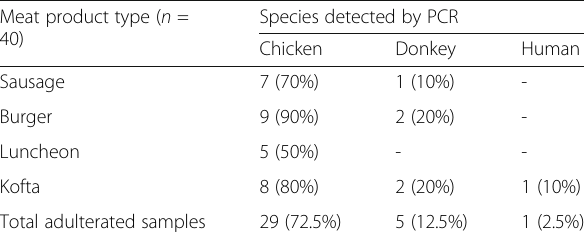
Table 2 Different species detected in authentication of processed meat products